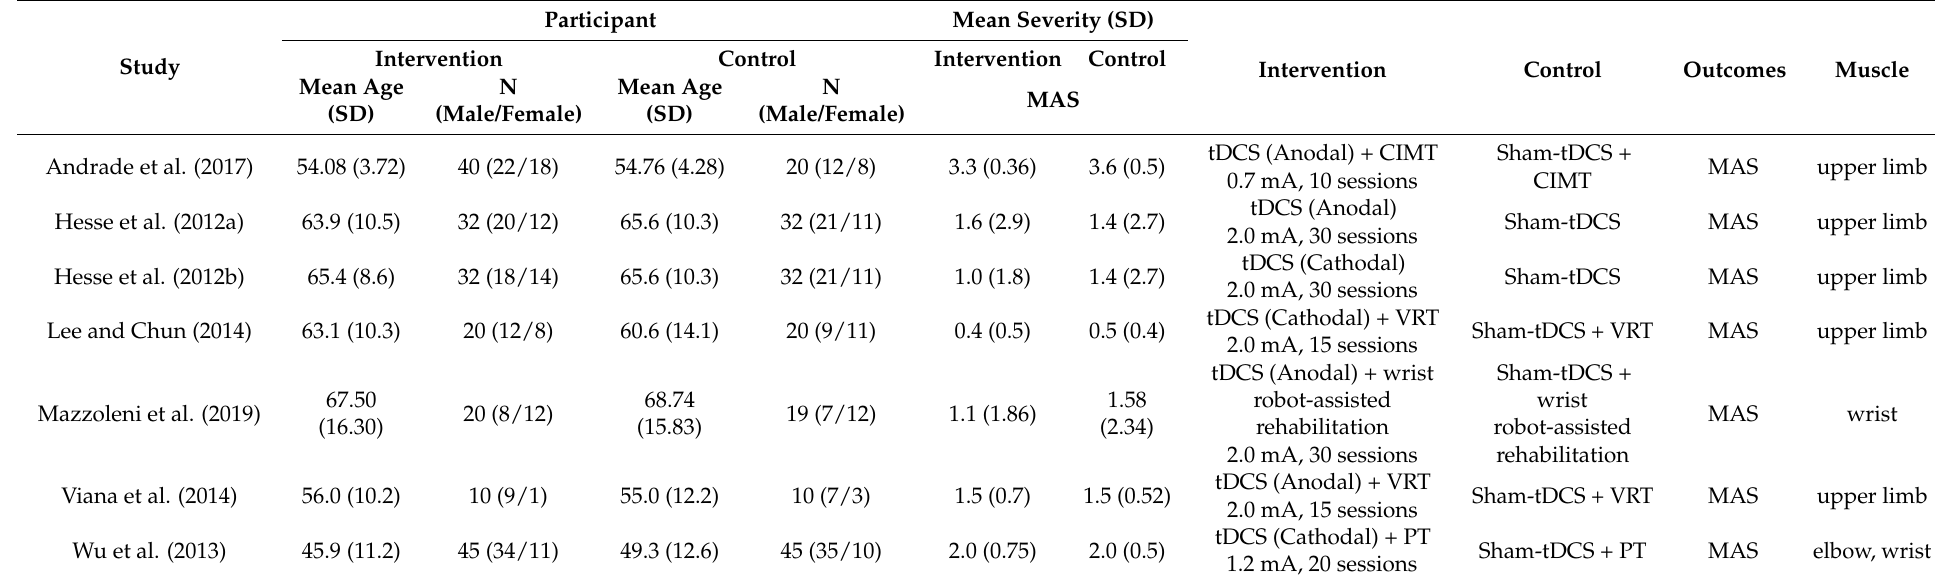
Table 2. Research Characteristics of